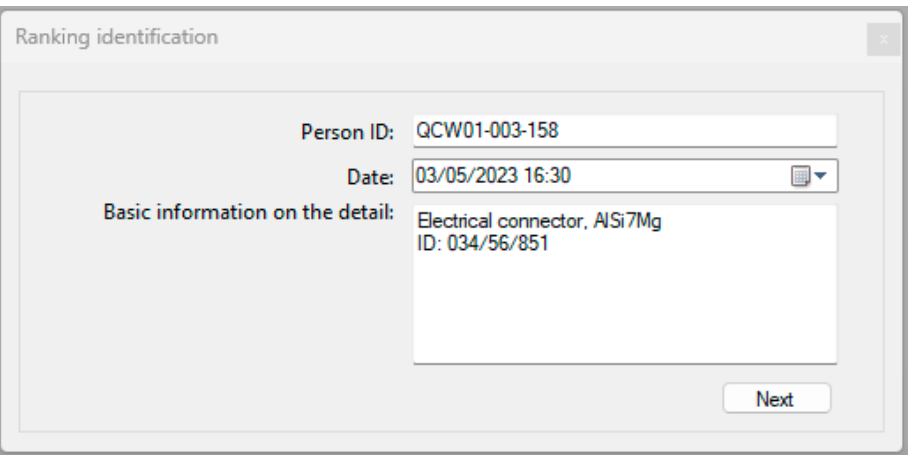
Figure 3. Prepare assumptions for the analysis of the energy intensity of detection methods used within the process under study.